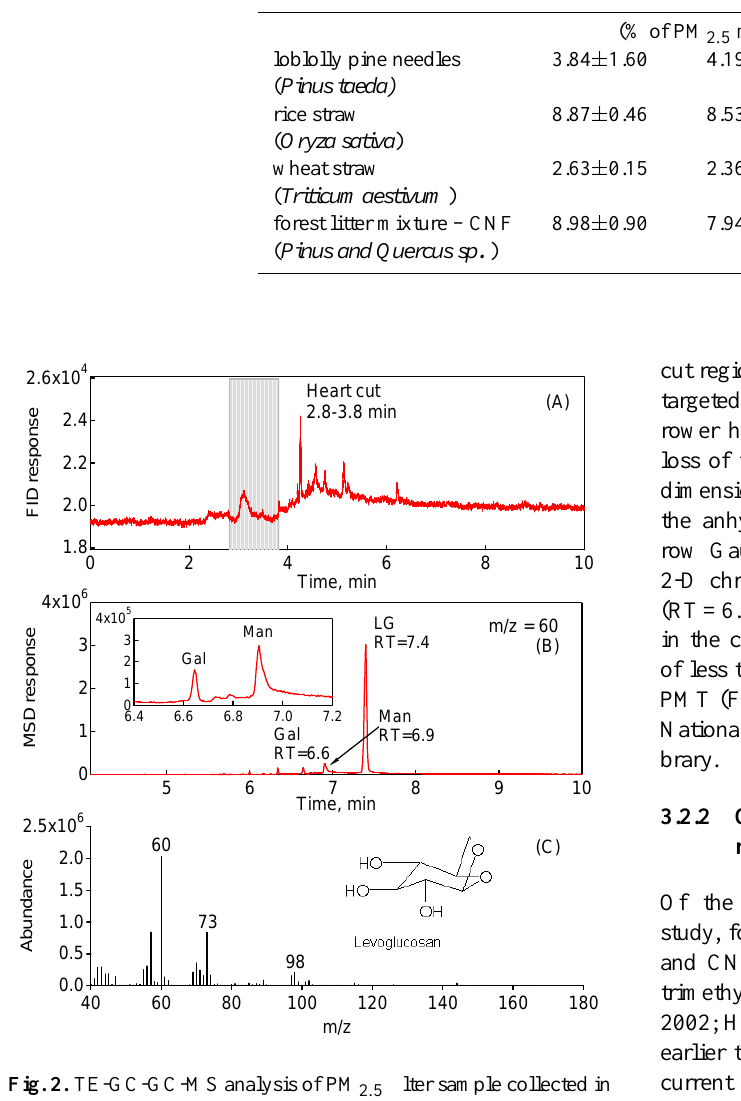
Fig. 2. TE-GC-GC-MS analysis of PM 2 . 5 filter sample collected in NC piedmont region (PMT). (a) FID response and selected 1min (2.8–3.8min) heart-cut region in grey. (b) Extracted ion chro- matogram at m/z =60 following the second dimension separation. Retention times of each anhydro-sugar are labeled. Inset shows the mannosan and galactosan at a resolution (Rs) > 3; Rs values > 1.5 indicate full resolution. (c) Mass spectrum of LG obtained at a re- tention time of 7.4